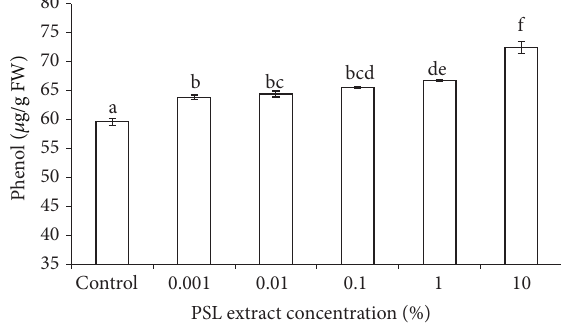
Figure 3: Effect of PSL extract on phenol content of wheat. Error bars represent Mean ± S.D of three different experiments. Data were subjected to one-way ANOVA analysis and differences among treatments were determined by Tukey’s test. Different letters mean statistical differences at 𝑃 < 0.05